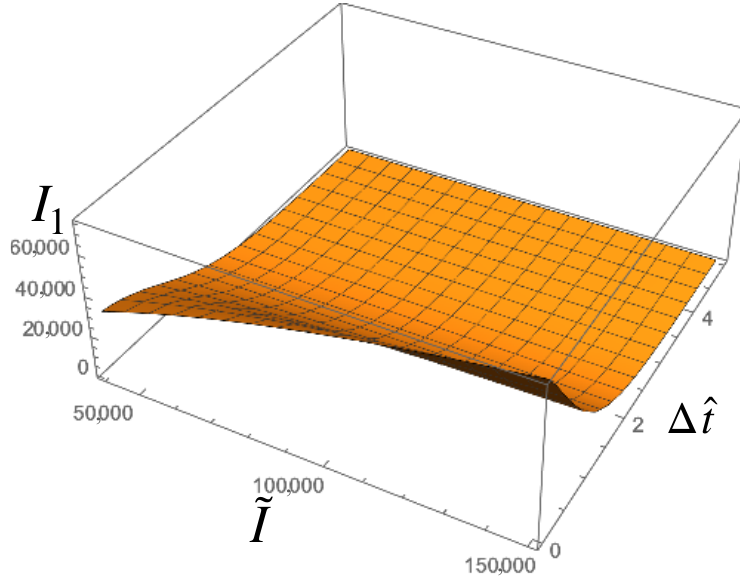
Figure 3. I 1 versus ˜ I and ∆ ˆ t in the range 50,000 ≤ ˜ I ≤ K IT